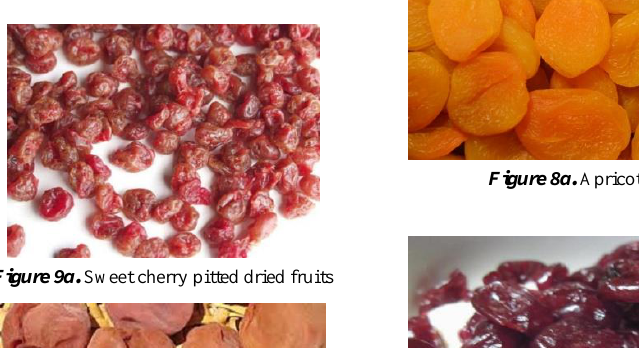
Figure 7b. Pear slices drying on the sun Figure 8b. Peach dried fruits